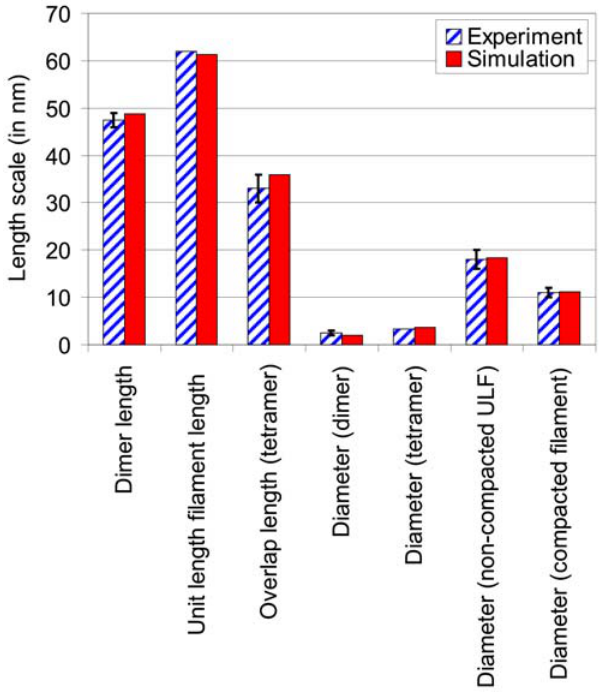
Figure 3. Comparison of structural properties of the IF dimer and tetramer between experiment and simulation (see also Table S1).